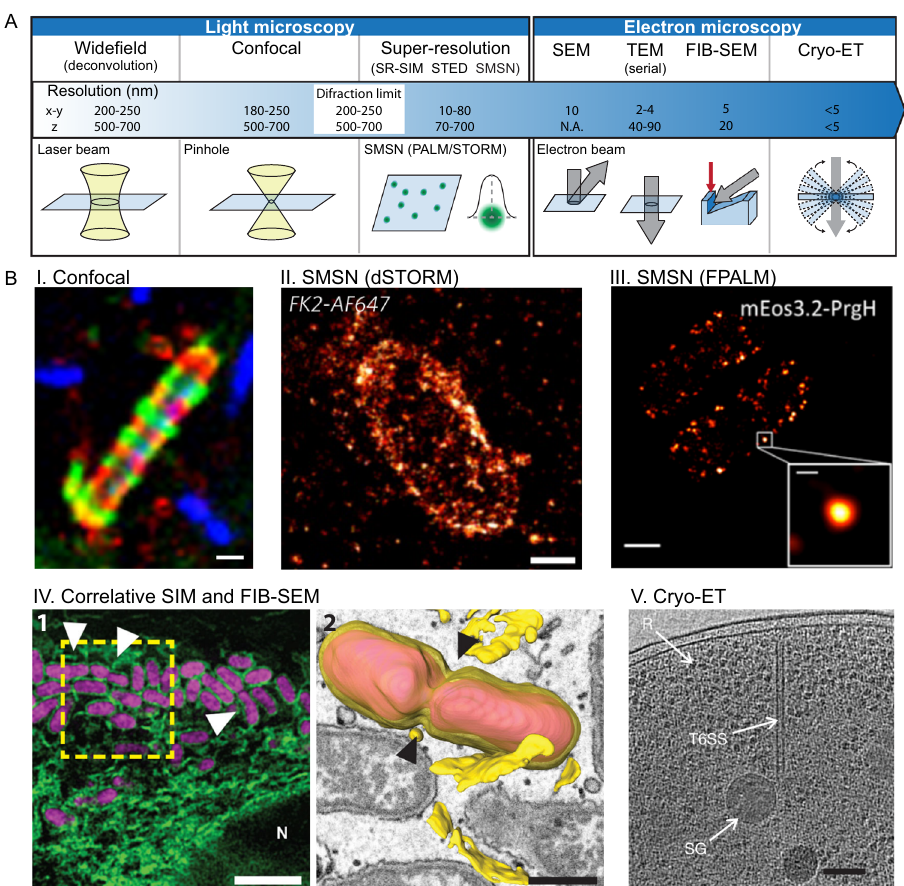
Fig. 1 State-of-the-art microscopy techniques recently used to visualise the infection process. A Scheme of selected microscopy techniques used for cellular microbiology, including diagrams and resolution. More detailed information on the x, y and z resolution of the different microscopy techniques is reviewed in Schermelleh et al. 3 . B I, Septin cage entrapment of cytosolic S. fl exneri imaged with confocal microscopy, scale bar = 1 μ m ( fi gure adapted from Mostowy et al. 95 ). II, Cytosolic S . Typhimurium decorated with ubiquitin visualised with dSTORM, scale bar = 1 μ m ( fi gure adapted from Van Wijk et al. 12 ). III, T3SS of S . Typhimurium observed by FPALM, scale bar = 0.5 μ m ( fi gure adapted from Zhang et al. 7 ). IV, B. abortus infection of HeLa cells expressing